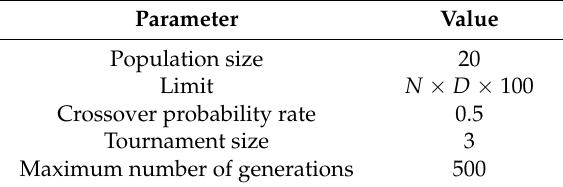
Table 1. Parameter settings of the Multi-Objective Artificial Bee Colony (MOABC) algorithm in the study.